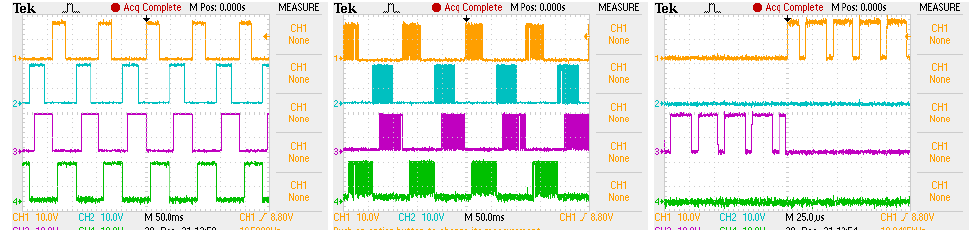
Figure 15. Oscillogram showing transistor control signals in case of a non-PWM power supply with a time base of 50 ms ( left picture), in case of a PWM power supply with a time base of 50 ms ( middle picture) and a power supply with PWM modulation with a time base of 25 µ s ( right picture), where in all figures orange is for the transistor T 1 , blue for the transistor T 2 , purple T 3 and green for T 4